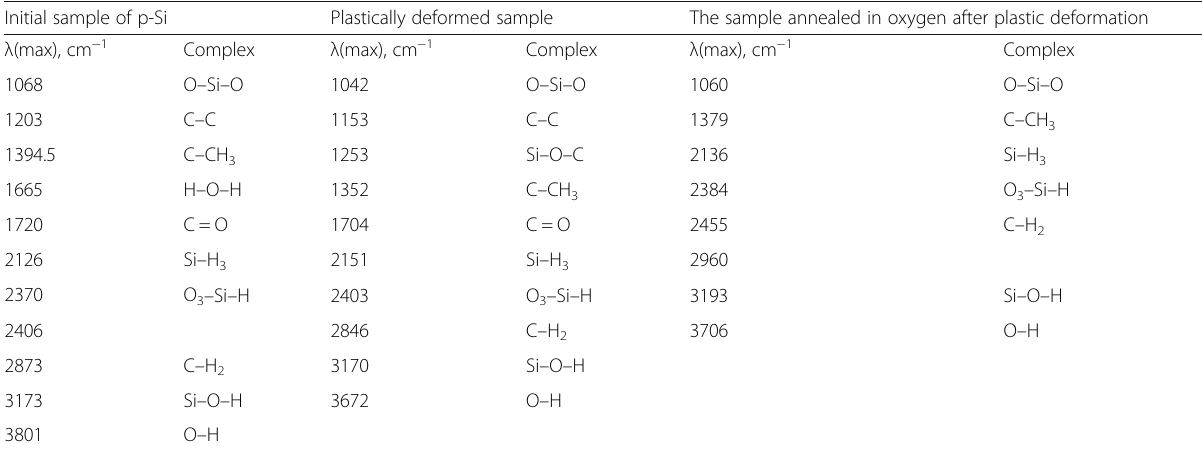
Table 1 Passband maximums and corresponding defect structures obtained from a comparative analysis of vibrational spectrum of silicon samples subjected to different treatment with the literature data Initial sample of p-Si Plastically deformed sample The sample annealed in oxygen after plastic deformation